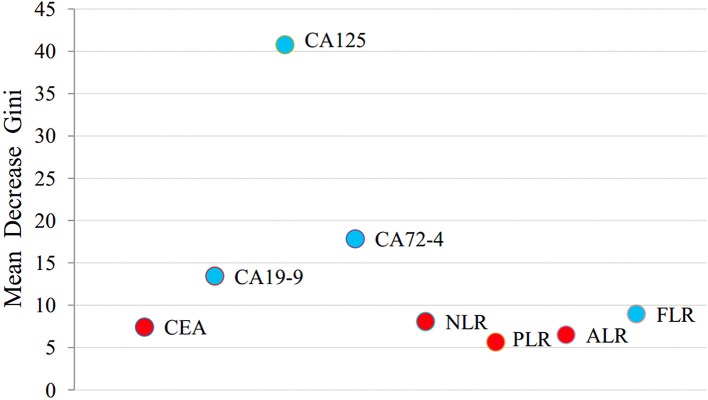
Random forest algorithm for ranking of the importance of all variables.